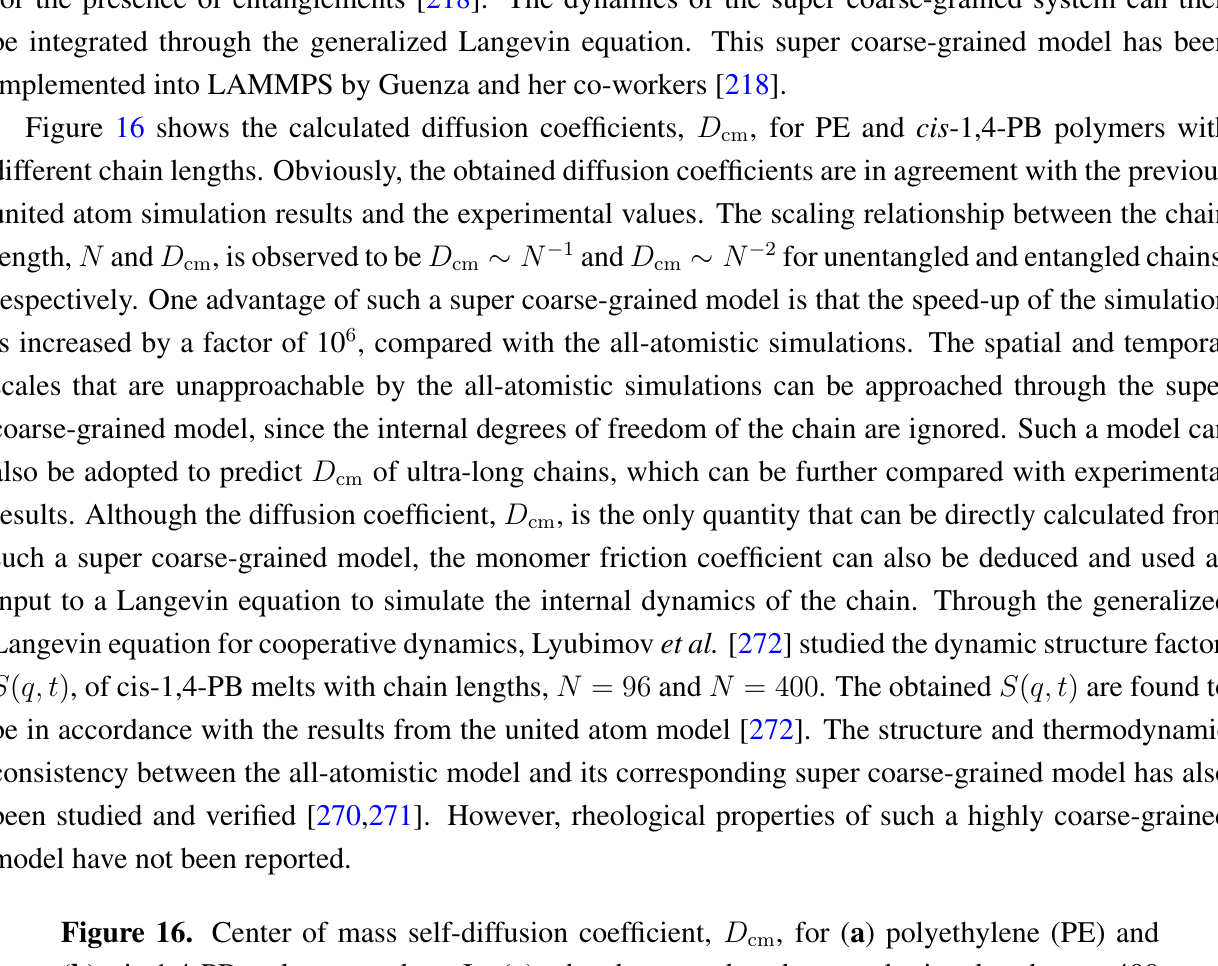
, for ( a ) polyethylene (PE) and cm